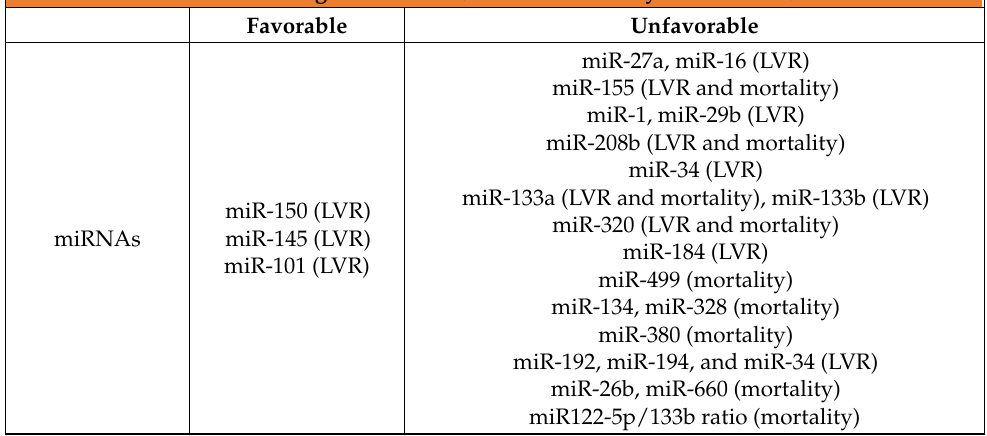
Table 1. miRNA as a prognostic